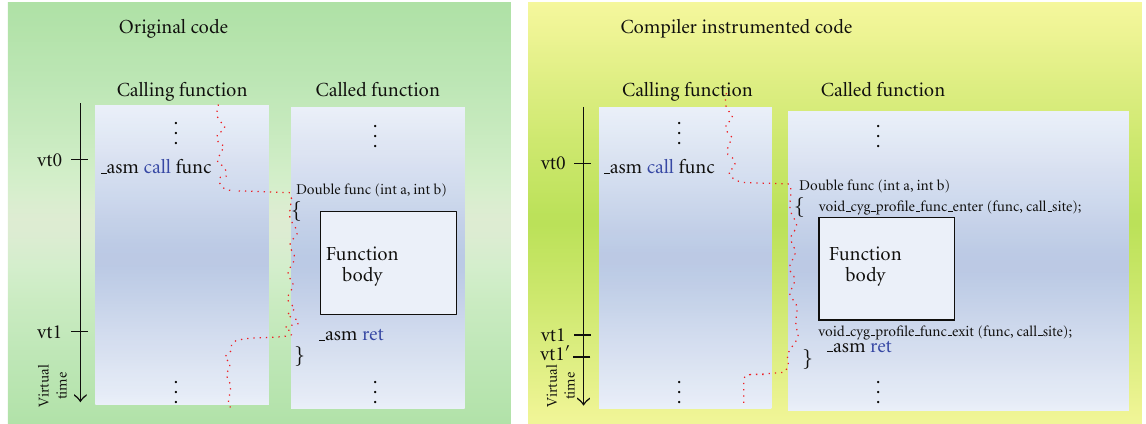
Figure 8: Gcc automatic compiler instrumentation.